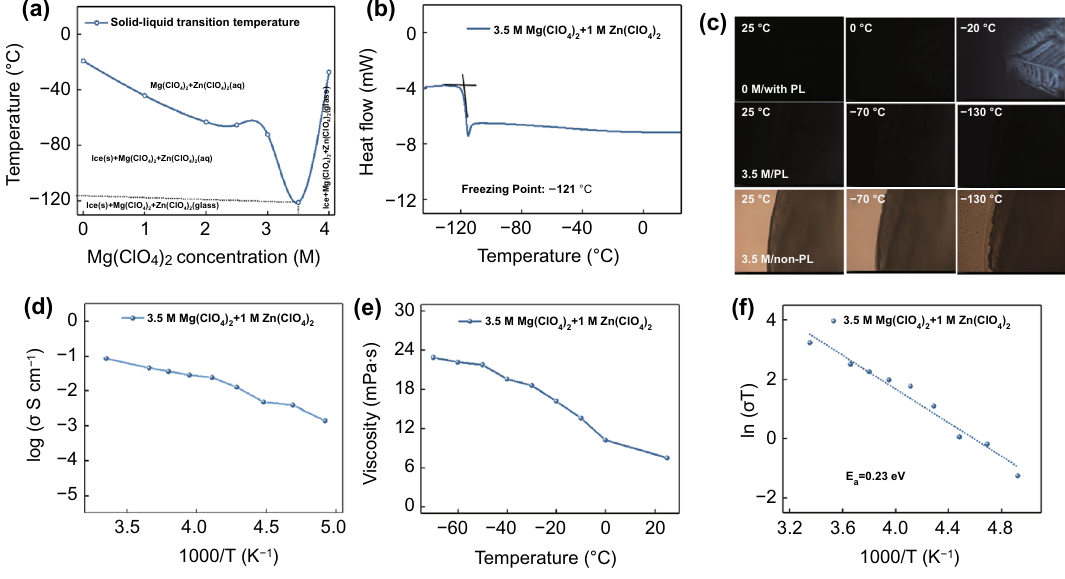
Fig. 2 a V-shape relationship between the freezing temperature and concentration of Mg(ClO 4 ) 2 (0 M refers to 1 M Zn(ClO 4 ) 2 ). b DSC curve of 3.5 M electrolyte. c Polarizing light (PL) and non-polarizing light microscope observation of 0 M and 3.5 M electrolyte. d Ionic conductivity of 3.5 M electrolyte at different temperatures. e Viscosity of 3.5 M electrolyte at different temperatures. f Electric conductance activation energy of 3.5 M